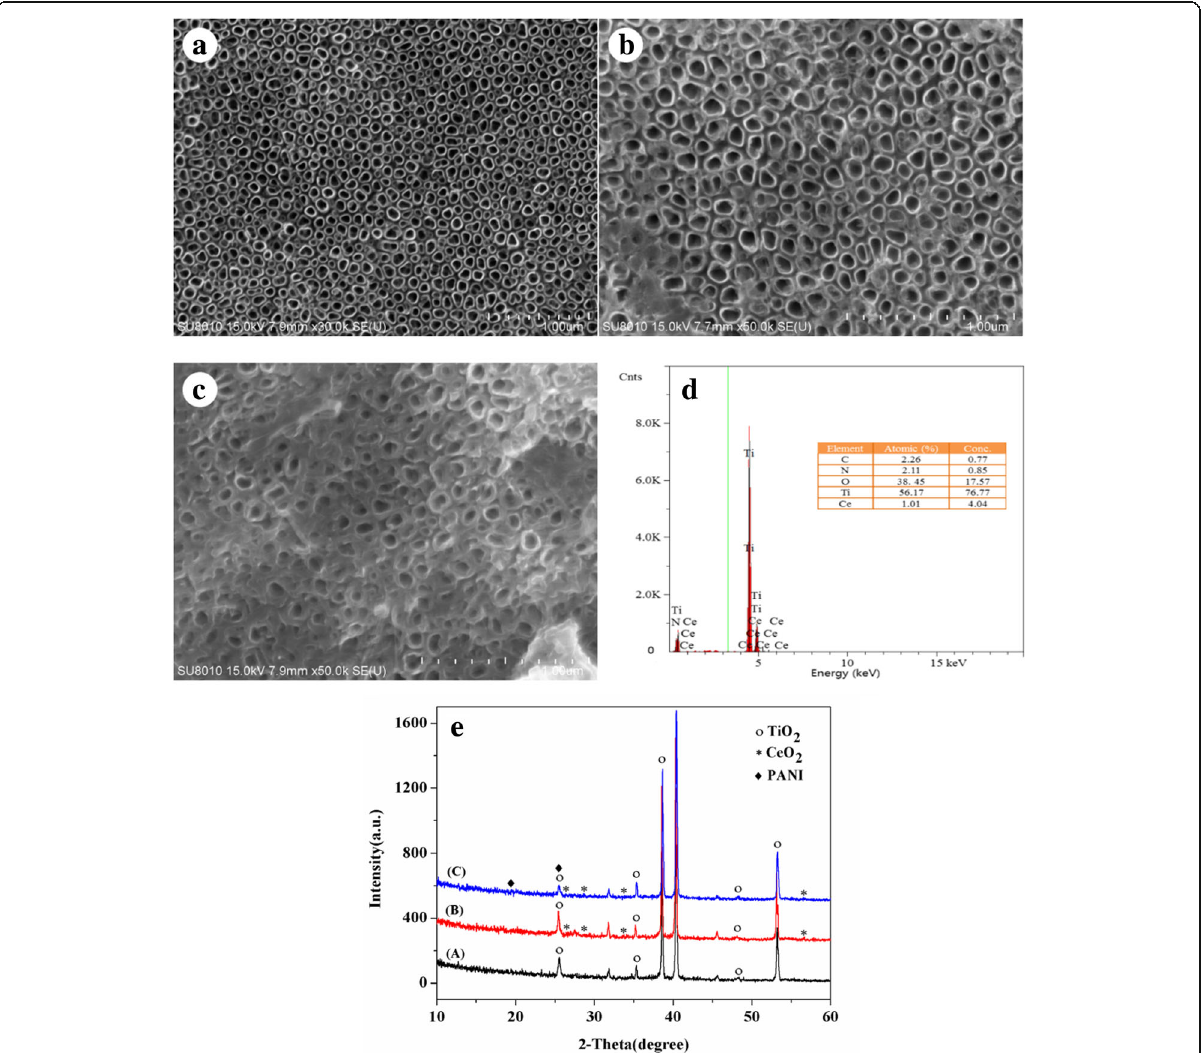
Fig. 1 SEM images of TiO 2 NTAs ( a ), CeO 2 /TiO 2 NTAs ( b ), PANI/CeO 2 /TiO 2 NTAs ( c ), and the EDS spectra of PANI/CeO 2 /TiO 2 NTAs ( d ), and XRD patterns of TiO 2 NTAs (A), CeO 2 /TiO 2 NTAs (B), and PANI/CeO 2 /TiO 2 NTAs (C) ( e